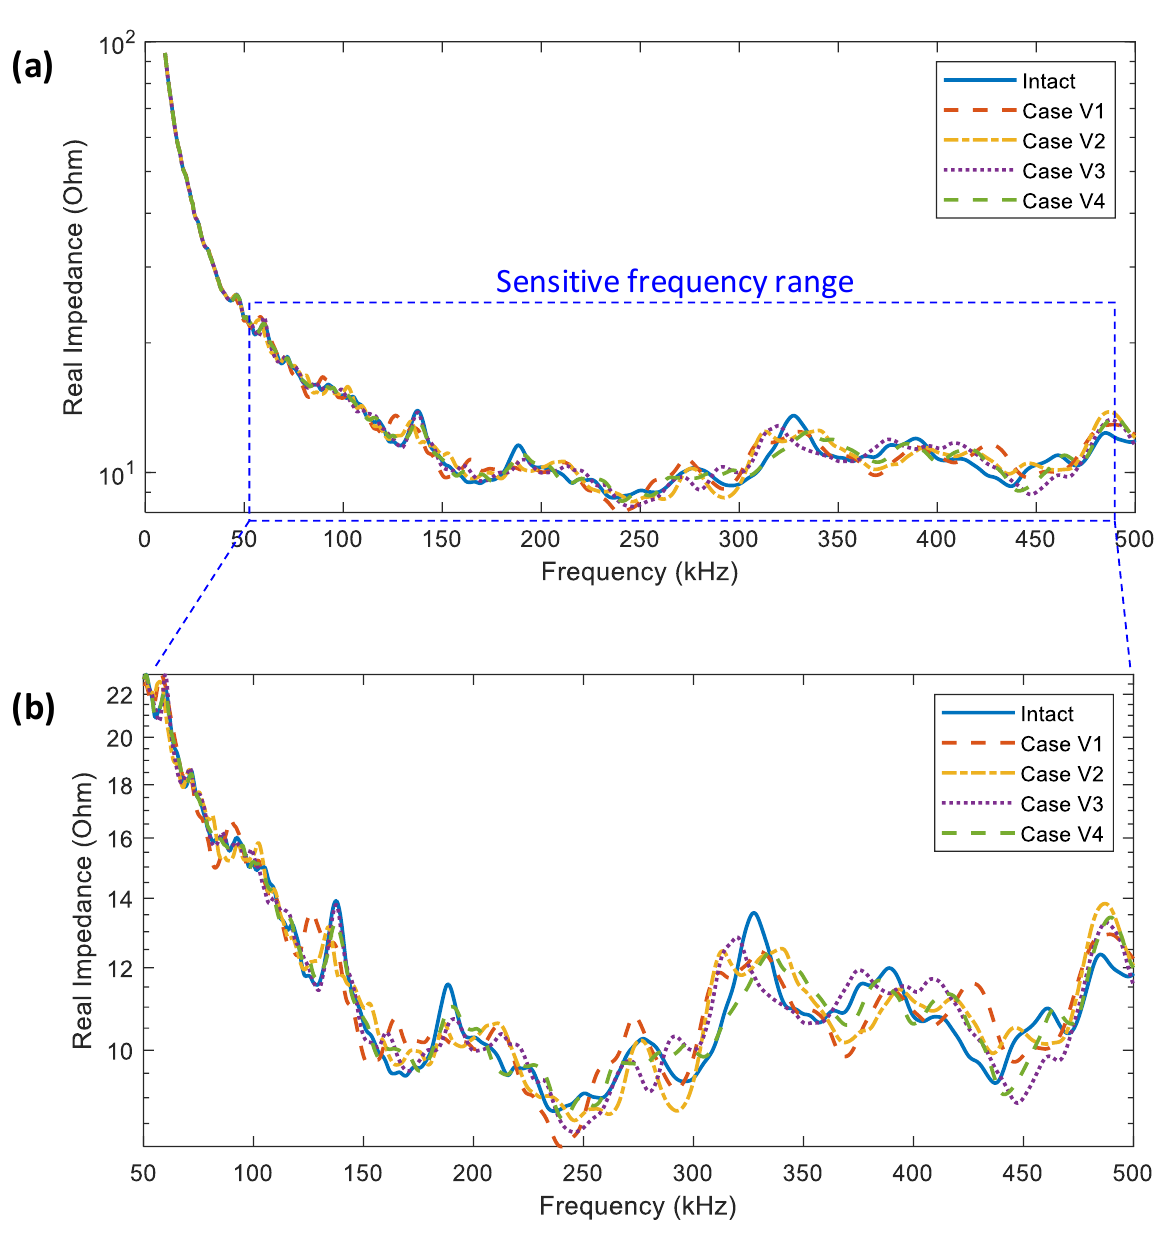
Figure 8. The EMI response of the anchorage under the intact case (not cracked) and vertical crack cases: ( a ) Frequency range of 10–500 kHz; ( b ) sensitive frequency range of 50–500 kHz.